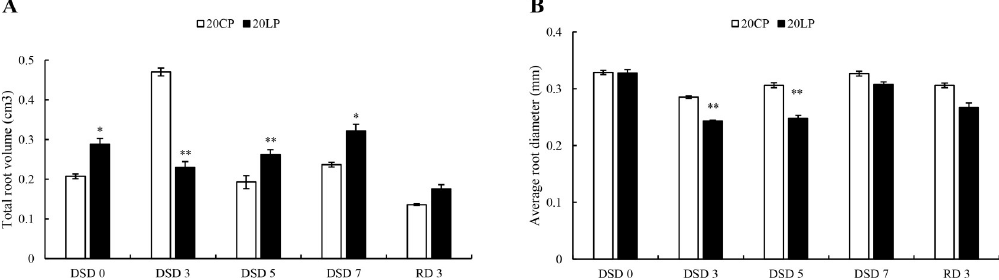
Fig 2. The total volume and average diameter of wheat roots. Note: CP: conventional phosphorus; LP: low phosphorus; Values are means ± standard deviation of three repetitions; � and �� indicate significantly different at p < 0.05 and p < 0.01, respectively. 20CP: Xindong20 under conventional phosphorus level; 20LP: Xindong20 under low phosphorus level.